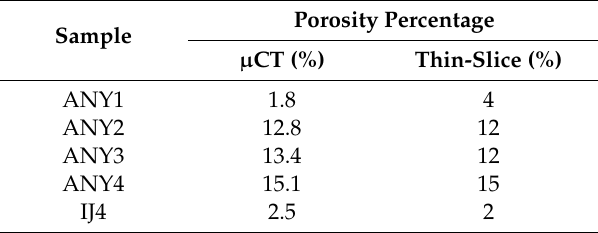
Table 4. Porosity percentage comparison between micro-CT method and thin-slice